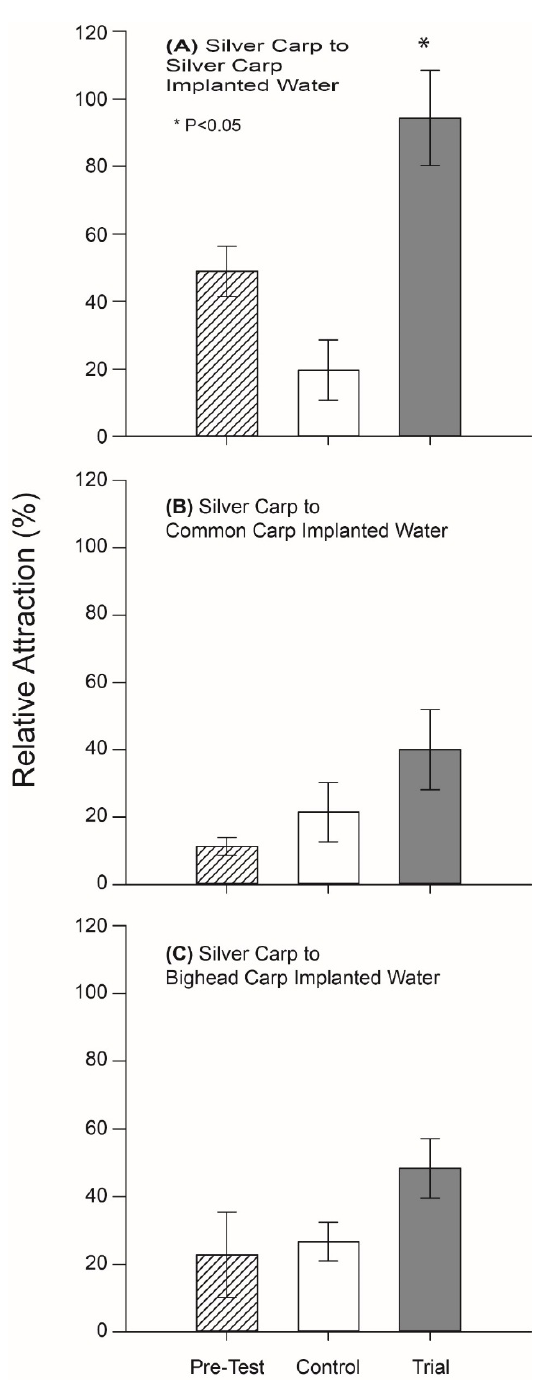
Figure 3. Distribution of masculinized Silver Carp in the rectangular test tank before and during tests of PGF 2 α -implanted carp odors. Mean percent time ( ± standard error) on the side to which the test odor was added is shown. Each experiment had three 10-min test periods during which time no stimulus was added (striped bar), following one in which well water control was added (open bar), followed by one in which a test stimulus was added (solid bar). Three sets of test stimuli were tested on different fish as follows: ( A ) PGF 2 α -implanted Silver Carp holding water, ( B ) PGF 2 α -implanted Bighead Carp holding water, and ( C ) PGF 2 α -implanted Common Carp holding water. n = 7 for each test. * p < 0.05 by 1-tailed paired t